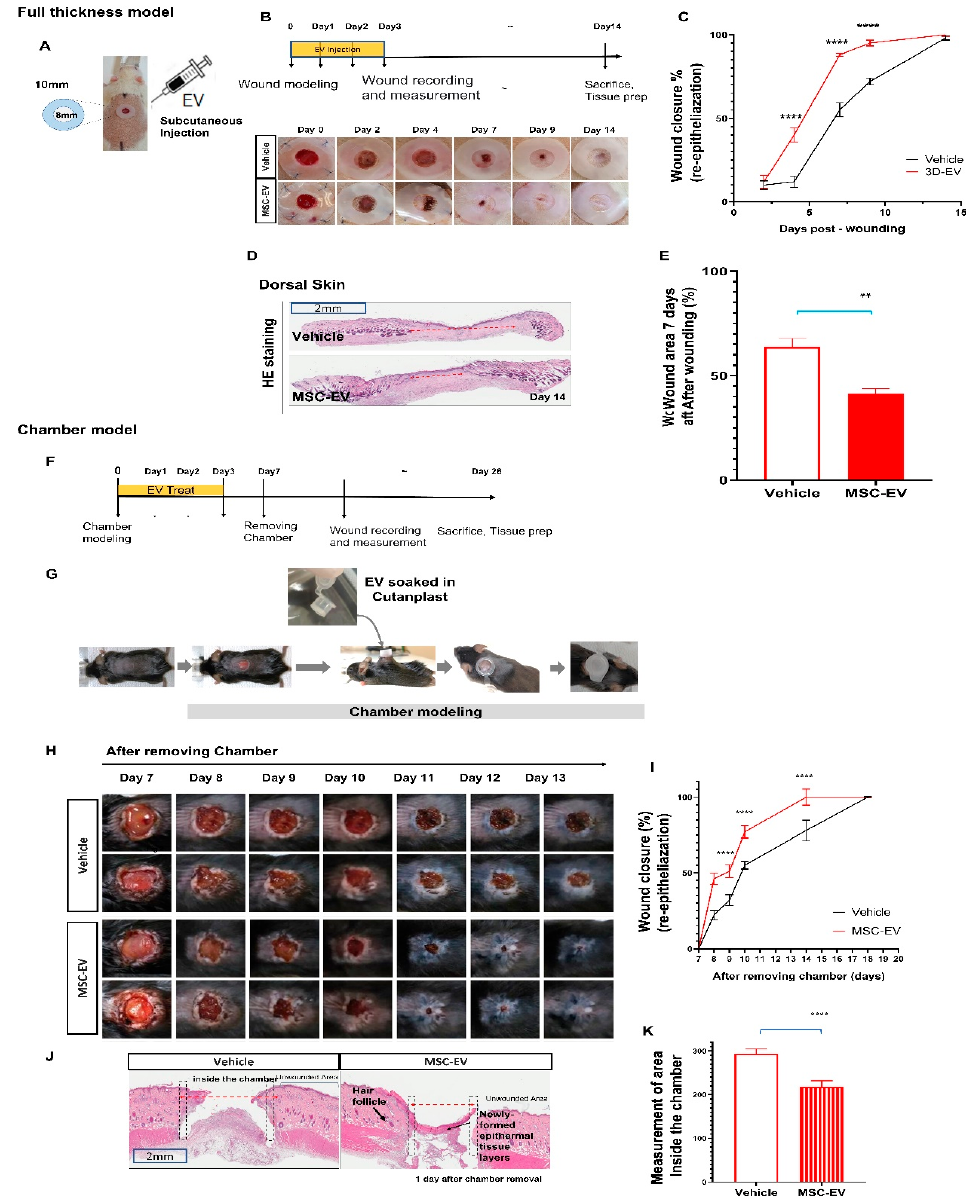
Figure 2. Evaluation of cutaneous wound healing in a conventional full-thickness rat wound model (upper panel) and a chamber mouse wound model (lower panel). ( A ) Schematic diagram of a full-thickness wound healing model ( B ) Representative image of a wound over 14 d. ( C ) Rate of wound closure (%, re-epithelialization) measured via histo-morphometric analysis of tissue sections. ( D , E ) Photomicrographs of hematoxylin and eosin (H&E)-stained histologic sections of wounded skin (Scanscope image, USA) 14 d post-wounding. Graph of measurements in panel E. ( F ) Schematic diagram of the time schedule of the wound chamber model. ( G ) Surgical processes for the mouse skin excisional wound model. ( H ) Workflow for evaluating the mouse skin chamber wound model. ( I ) Increase in both wound closure percentage and the ratio of the area of granulation tissue to the wound field was observed in EV-treated mice. ( J ) Photo data of wound healing 1 d after chamber removal. ( K ) Semiquantitative evaluation of the gap width. Measurement of wound area percentage in the chamber. Thickness of the newly formed epidermis and measurement of the wound area inside the chamber. The number of animals used at each time point was six. Data represent the mean ± standard deviation (SD). **** p < 0.0001, ** p < 0.01.